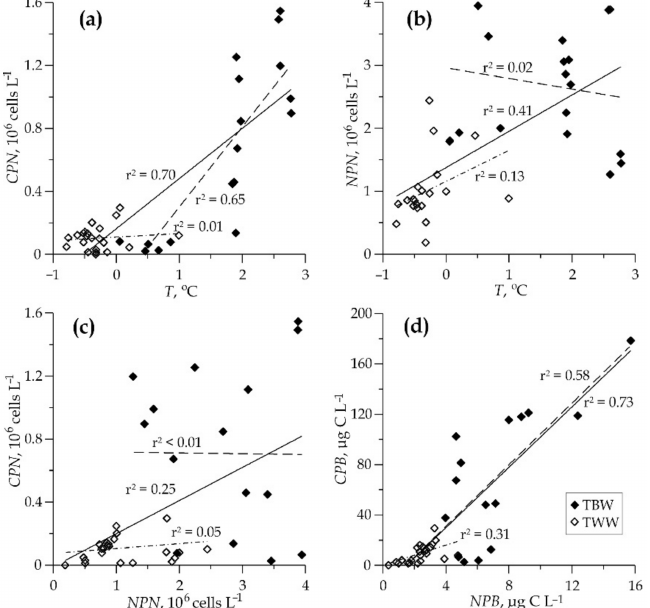
Figure 6. Relationships between: ( a , b ) the abundance of each group ( CPN , NPN ) and water tem- perature ( T ); ( c ) the cryptophyte ( CPN ) and other nanophytoplankton ( NPN ) abundances; ( d ) the cryptophyte ( CPB ) and other nanophytoplankton ( NPB ) biomasses. Samples from TBW (above 1 ◦ C isotherm) and TWW (below 1 ◦ C isotherm) water masses are represented with filled and empty symbols, respectively. Solid lines are regressions for the entire set of data, dashed ones are for individual biotopes. Description of the variables is in Table